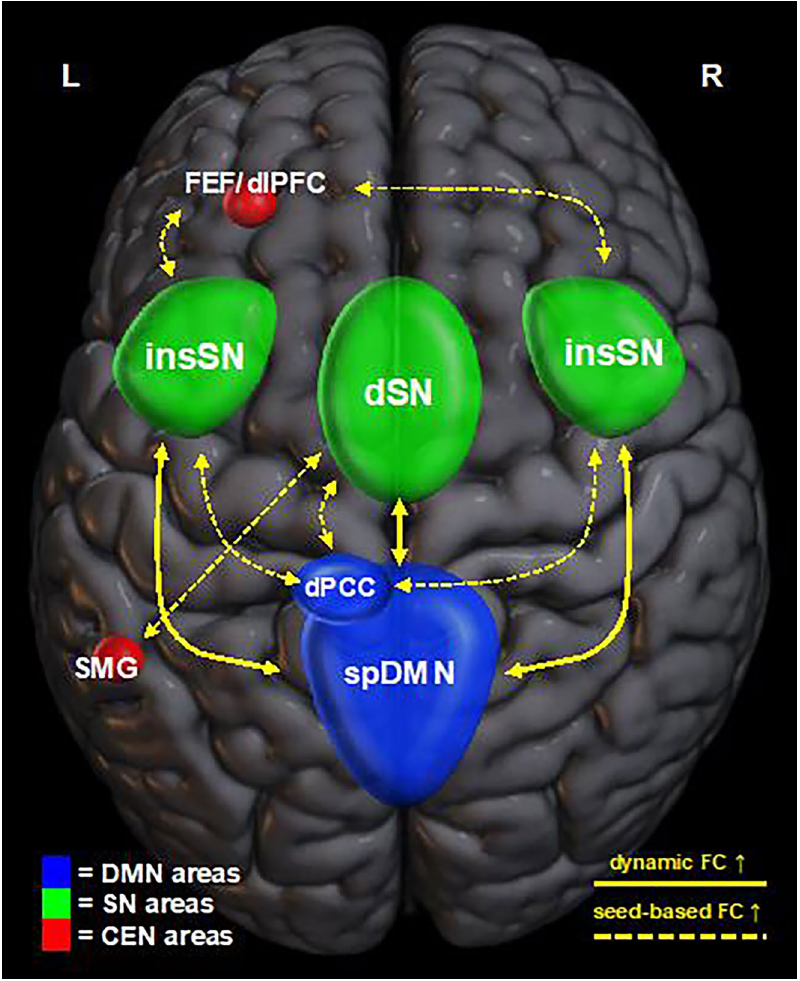
Figure 5. Schematic display of mindfulness-induced interaction patterns revealed through dynamic functional connectivity (FC) (solid lines) and seed-based FC analysis (dashed lines). Visualized with help of MRIcroGL v1.2.20210317 (https:// www. nitrc. org/ proje cts/ mricr ogl) 44 . Default mode network (DMN) associated areas are depicted in blue, salience network (SN) areas in green and central executive network (CEN) associated areas in red. Results from dynamic FC and seed-based FC reproduced highly similar interaction patterns between DMN and SN areas. Besides, SN regions showed increased FC with areas associated with the CEN. FEF/dlPFC Frontal eye field/dorsolateral prefrontal cortex, insSN insular salience network, dSN dorsal salience network,